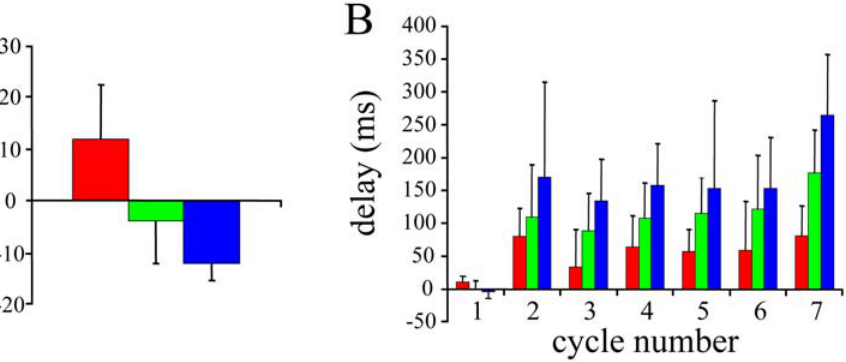
Figure 6. Summary of the timing of activity in different cycles within episodes evoked by a stimulus to the dorsal root. A. Sequence of activity for the first cycle in 5 experiments in which the dorsal optical activity preceded the onset of the electrical activity. B. Average delays of the optical signals measured from the onset of the ipsilateral electrical activity for 7 experiments. Time 0 corresponds to the onset of slow electrical activity recorded from the ipsilateral ventral root. The color code is the same as in the previous figures. Data are mean 6